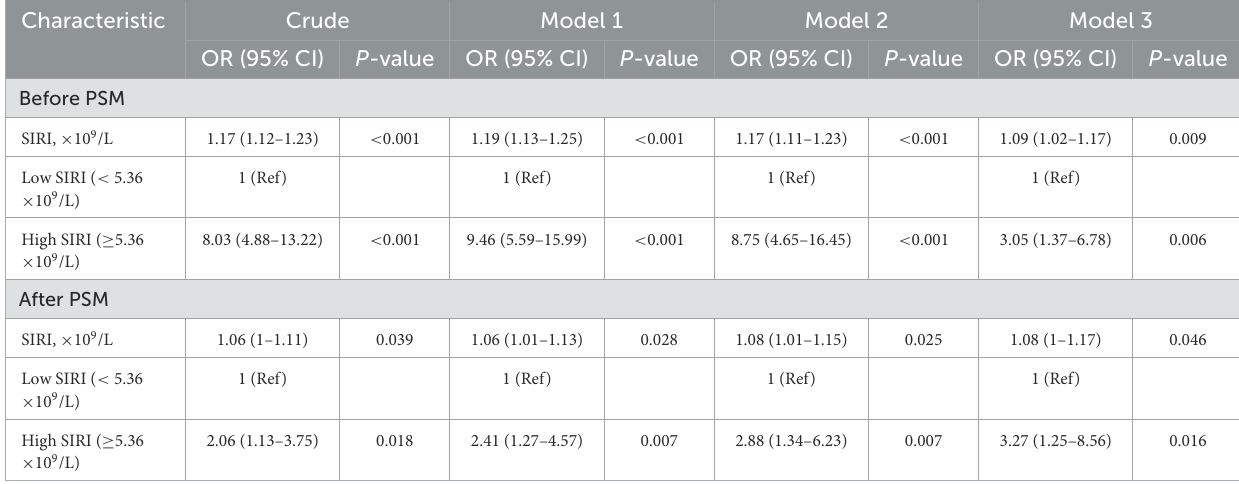
Model1:Adjustedforage,gender. Model2:Model1pluscomorbiditiesandcomplications(pneumonia,hydrocephalus,hypertension,hyperlipidemia,diabetesmellitus,smokinganddrinking). Model3:Model2plusvariablesrelatedtodiseaseseverity(GCSgrade,Hunt-Hessgrade,WFNSgrade,mFishergrade,ICHandIVH). aSAH,aneurysmalsubarachnoidhemorrhage;PSM,propensityscorematching;OR,oddsratio;CI,confidenceinterval;SIRI,systemicinflammationresponseindex;GCS,GlasgowComaScale;